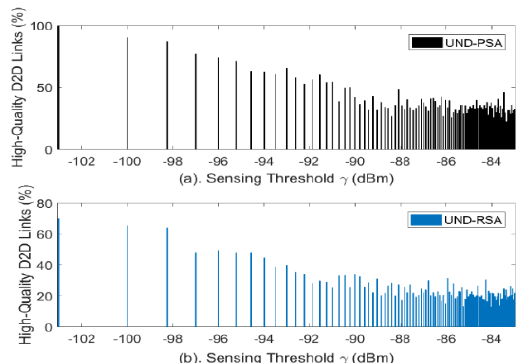
Figure 8. The percentage of D2D links with the desired quality of service (QoS) vs. the cognitive radio sensing threshold 𝛾 (in dBm) for both the RSA and PSA policies. Higher 𝛾 : moving toward the non-cognitive D2D scenario. Lower 𝛾 : moving toward the cognitive D2D scenario.